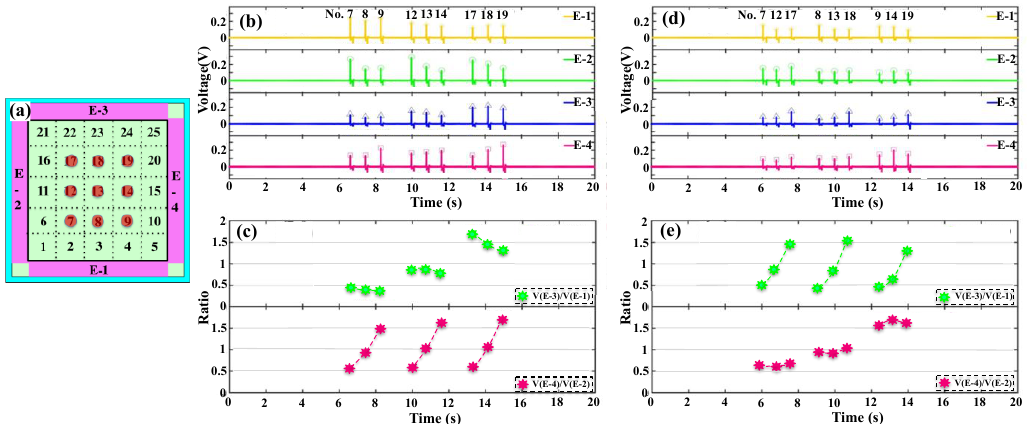
Figure 5. ( a ) Schematic illustration of the nine touch points at the center of the device; ( b ) The output voltage values and ( c ) the ratios ( V (E-3)/ V (E-1) and V (E-4)/ V (E-2)) of the nine continuous touches in the direction from E-2 to E-4; ( d ) The output voltage values and ( e ) the ratios ( V (E-3)/ V (E-1) and V (E-4)/ V (E-2)) of the nine continuous touches in the direction from E-1 to E-3.